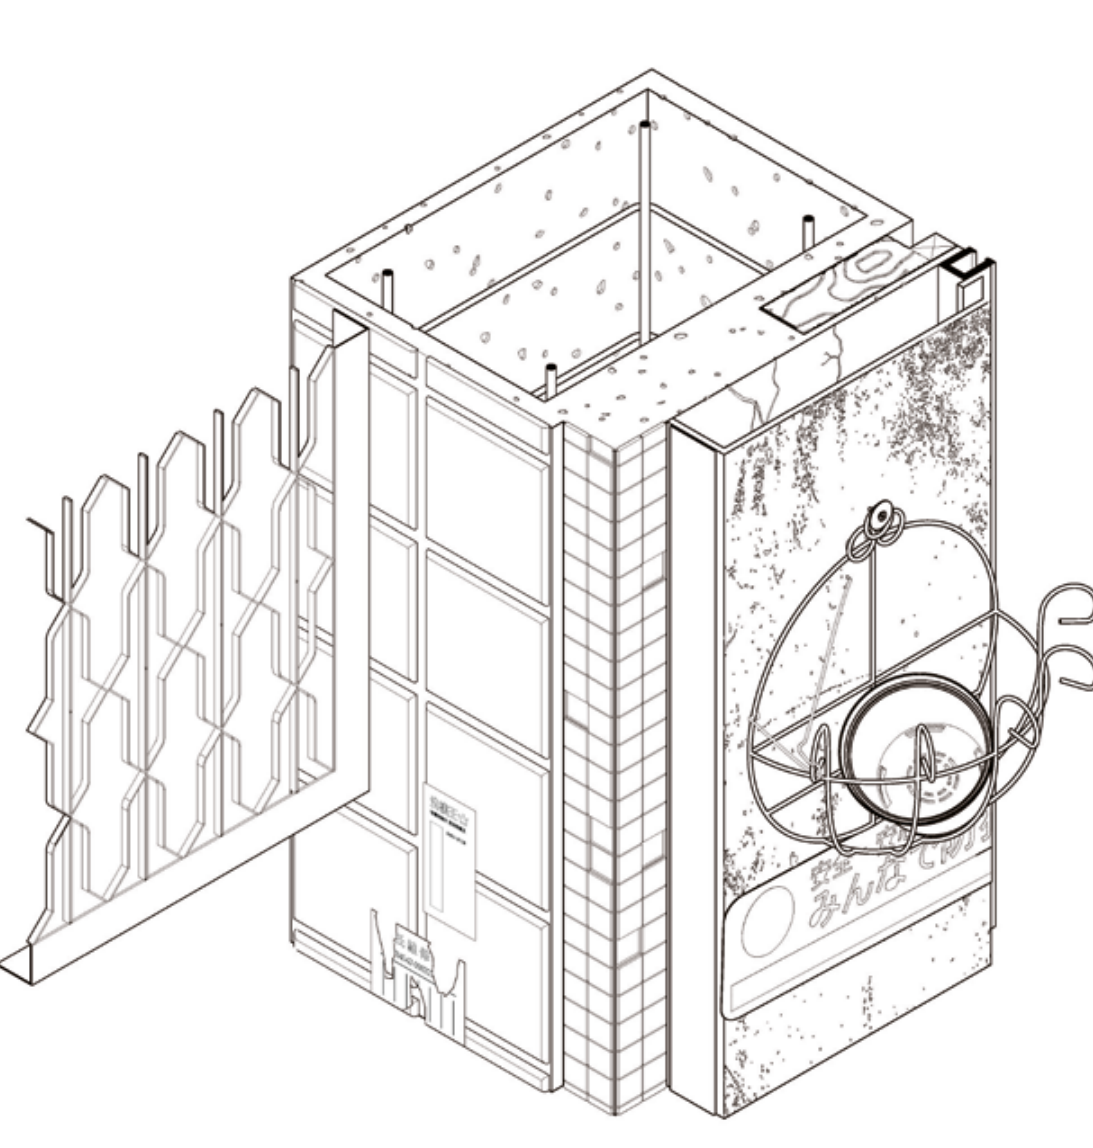
Figure 3: Vertical Studio Verisimilitude , 2018. Digital isometric drawing. Source: Chou Yu Hsuan, Kam Kwan Yin and Wan Tsz Yu,